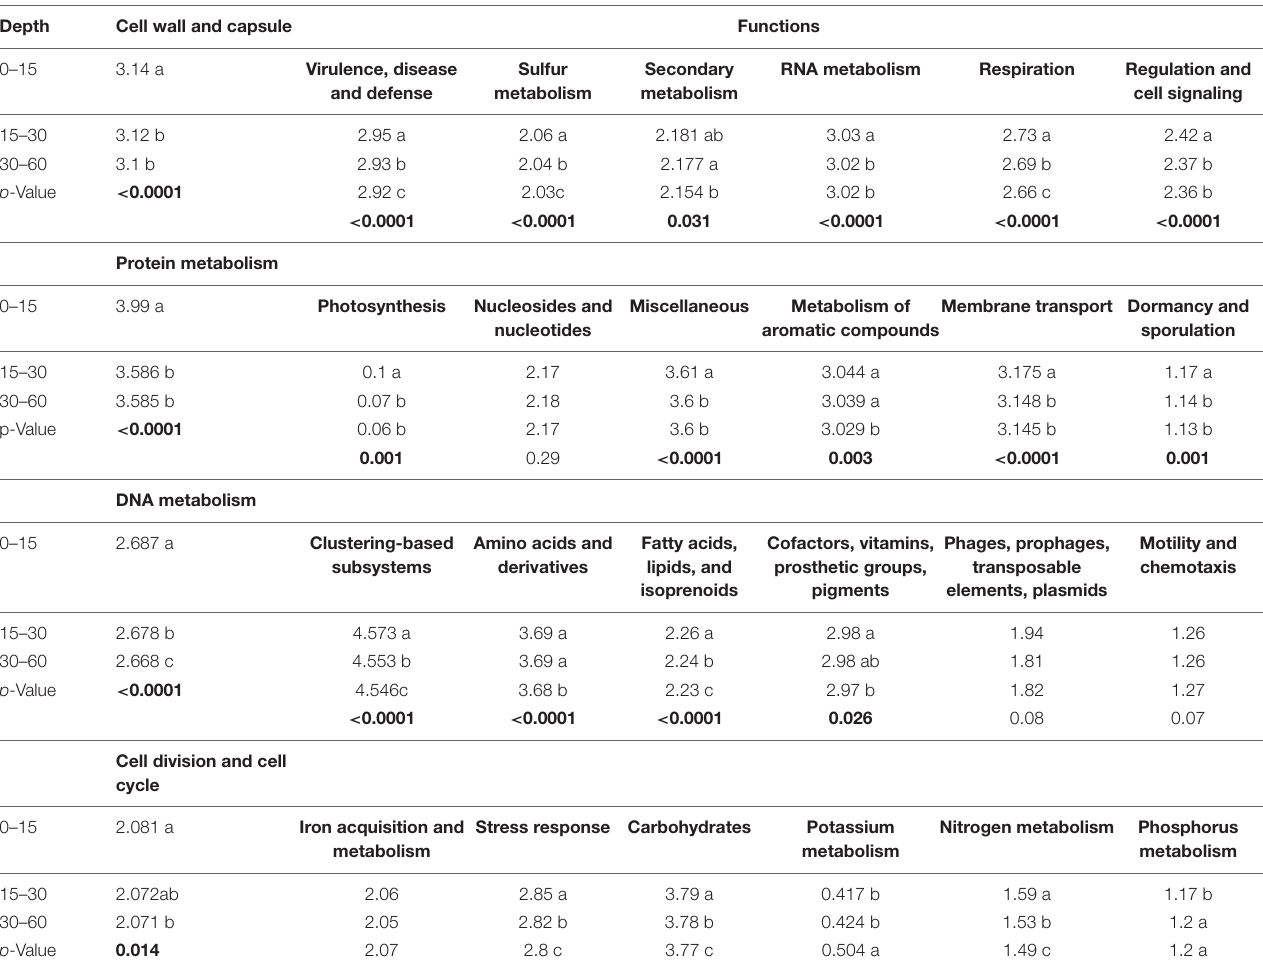
TABLE 2 | Least square means of Shannon index and probability of depth effects on subsystem level 1 functions detected in different soil depths. Values are means ( n = 15).